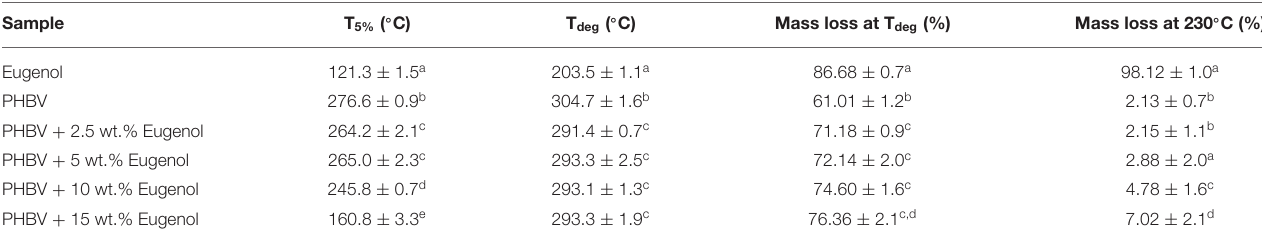
a − e Different superscripts within the same column indicate significant differences among samples (p < 0.05).